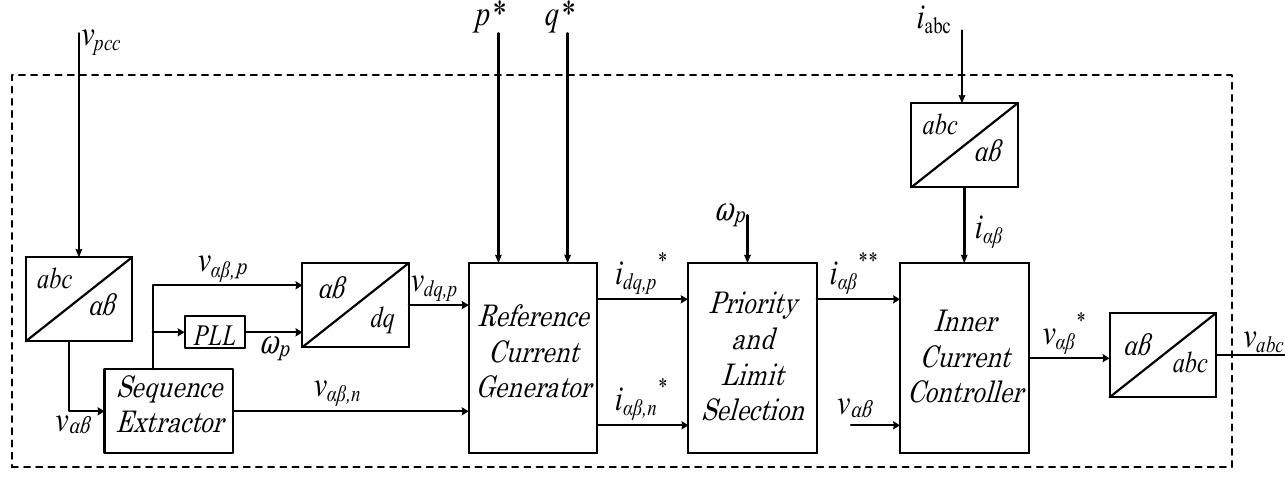
Figure 4. Proposed control scheme